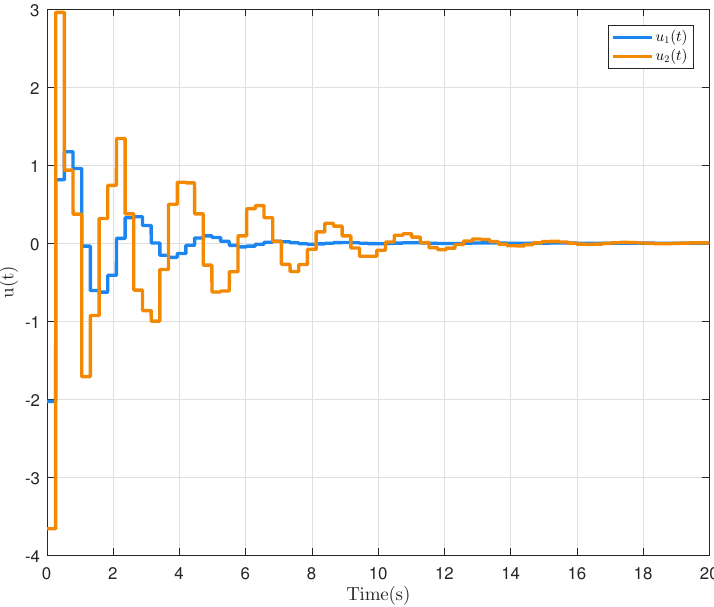
Figure 6. Control input u ( t )